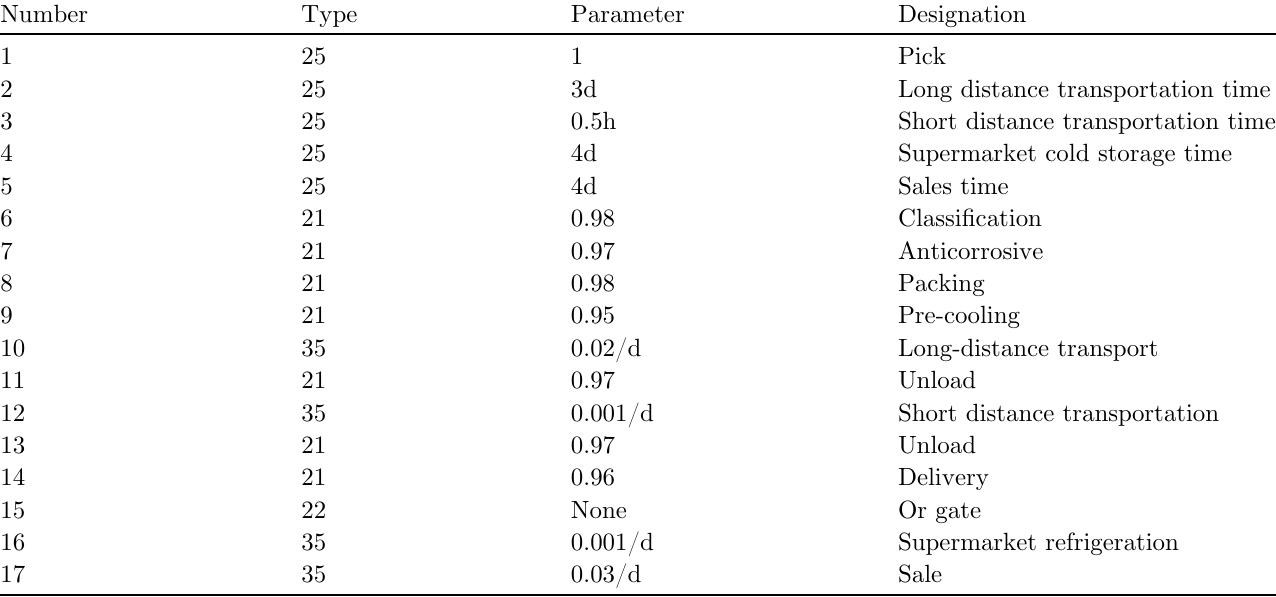
Table 1. Operator data.